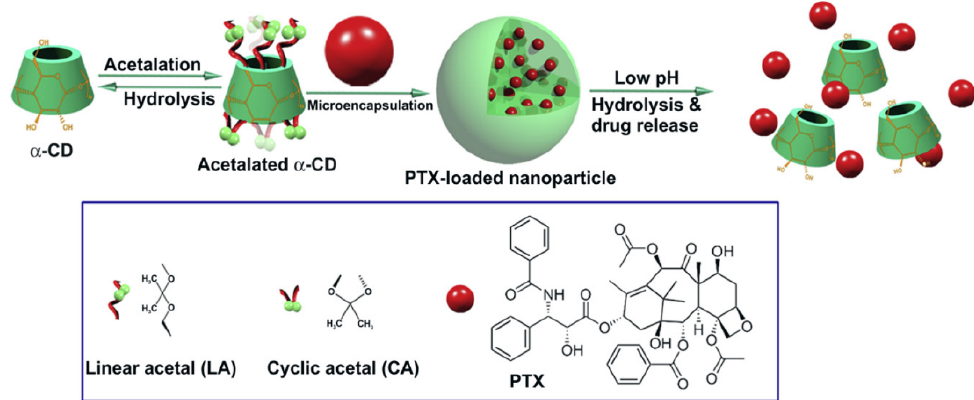
Figure 4. Schematic illustration of the construction of pH-sensitive PTX nanoformulation based on acetylated a-CD (Ac-aCD). (Adapted with permission from Ref. [40]. Copyright © 2013 Elsevier acetylated a-CD (Ac-aCD). (Adapted with permission from Ref [40]. Copyright © 2013 Elsevier Ltd).